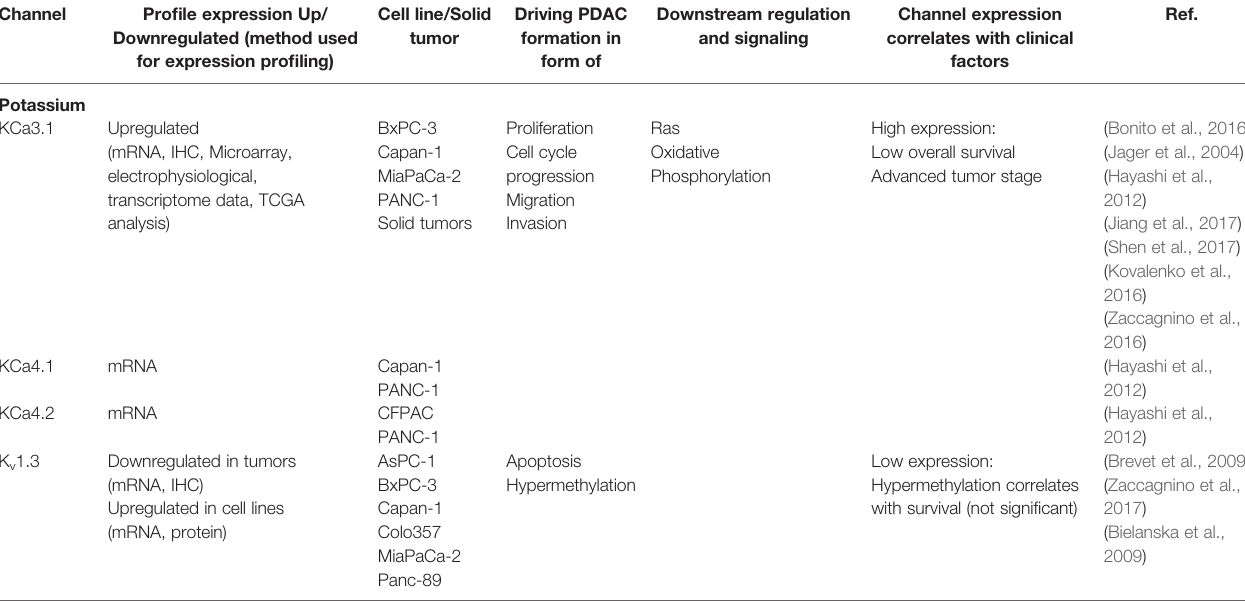
TABLE 2 | Pro fi le expression of ion channels in pancreatic ductal adenocarcinoma (PDAC) cell lines and tissue and how they are involved in driving PDAC formation and how channel expression correlate with clinical factors. Channel Pro fi le expression Up/ Cell line/Solid Driving PDAC Downstream regulation Channel expression Downregulated (method used tumor formation in and signaling correlates with clinical for expression pro fi ling) form of factors